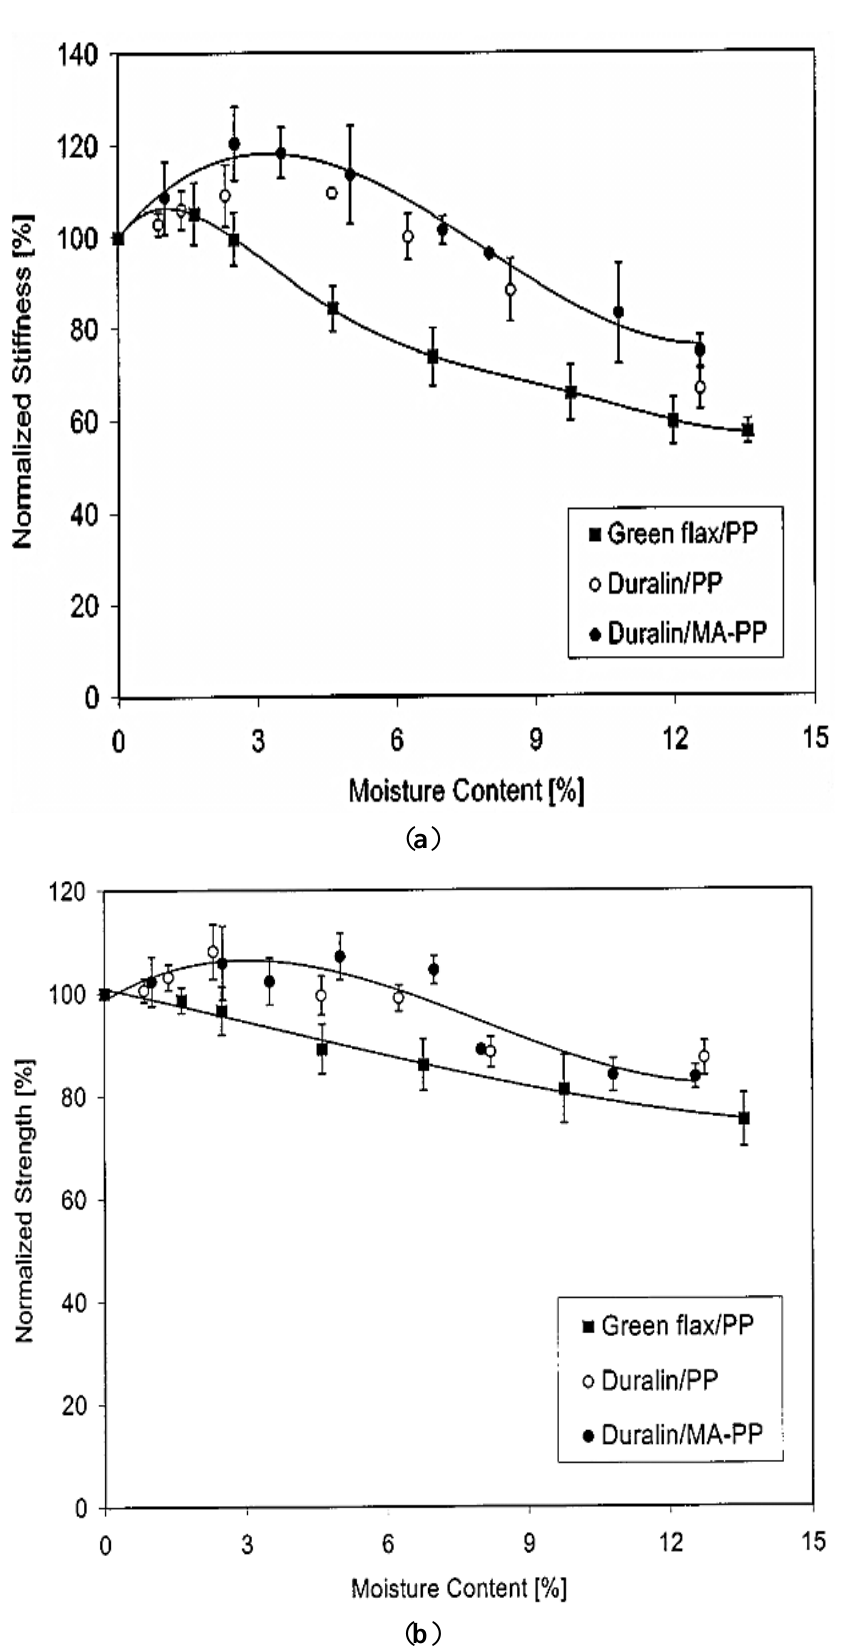
Figure 7. Moisture content versus mechanical properties: ( a ) stiffness; ( b ) strength Adapted with permission from [69]. Copyright 2013 by